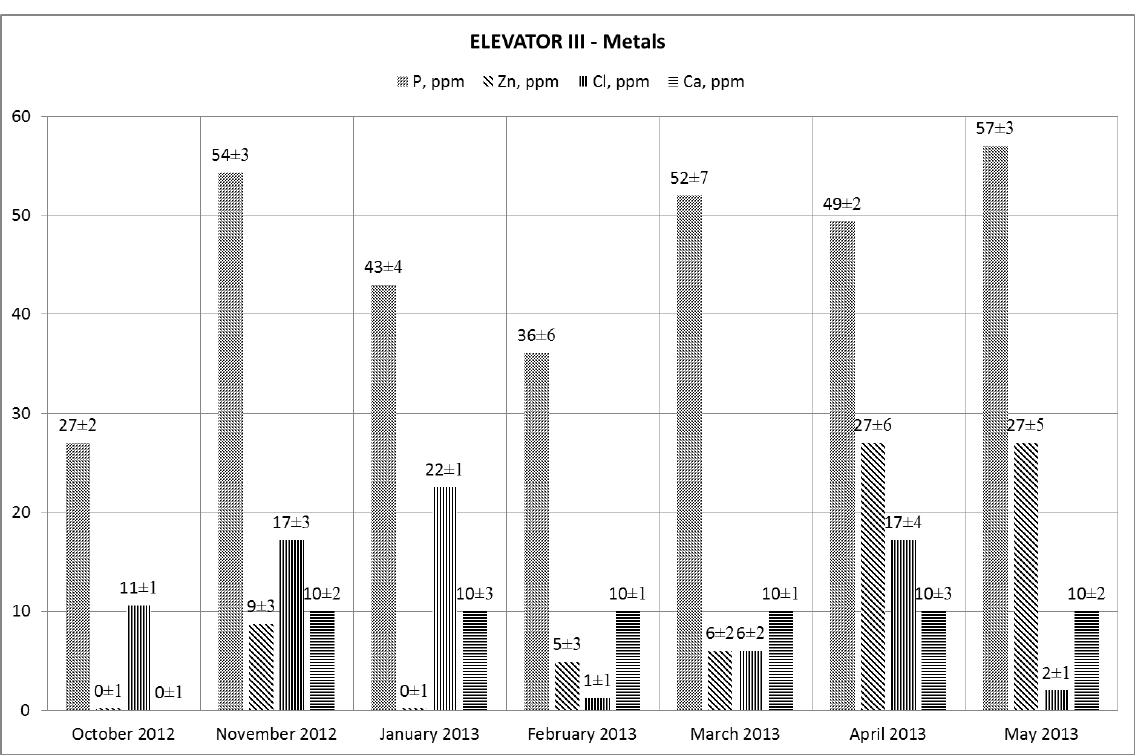
Figure 10. Metals in Elevator